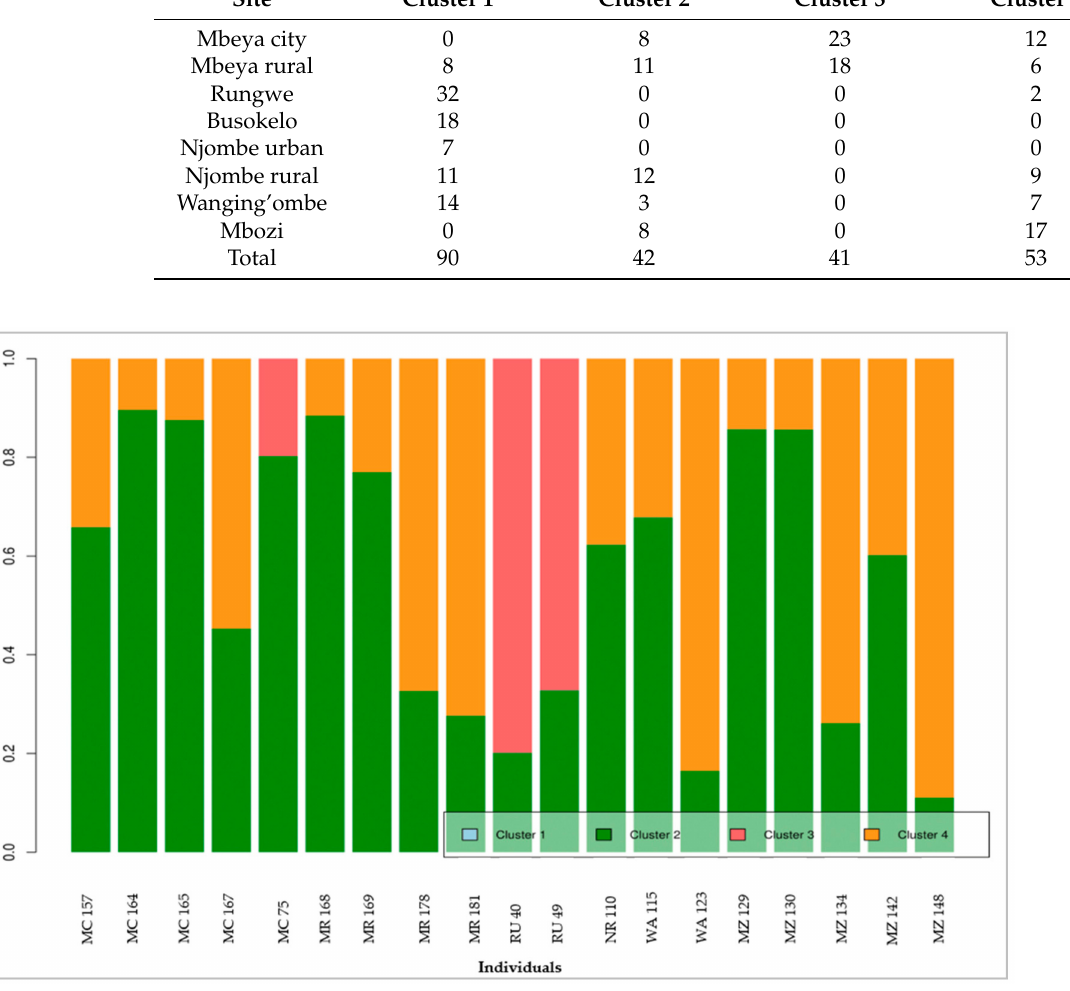
Figure 5. The distribution pattern of the alleles of different clusters for the most admixed individuals revealed by